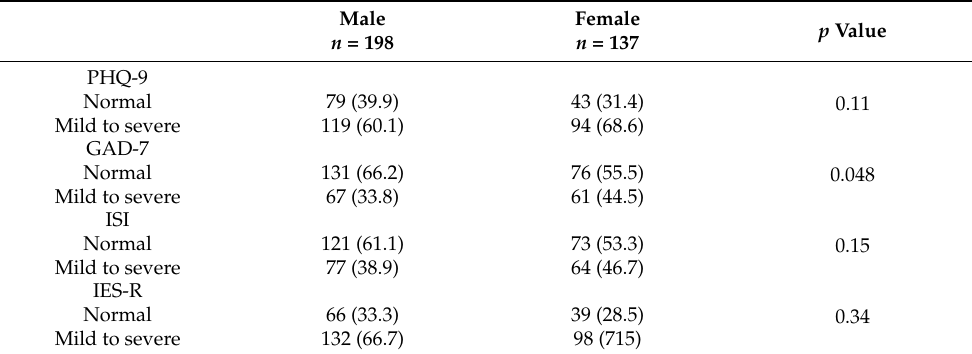
Table 3. Differences in mental health status according to